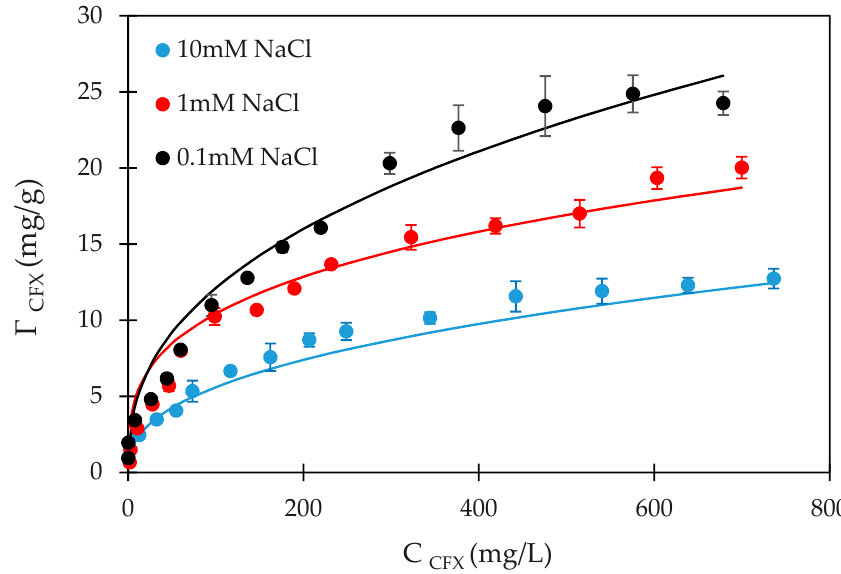
Figure 7. Adsorption isotherms of CFX onto PMA at different NaCl concentrations. Points are experimental results while solid lines are fitted by the two-step adsorption model. Error bars show standard deviation of three replicates .